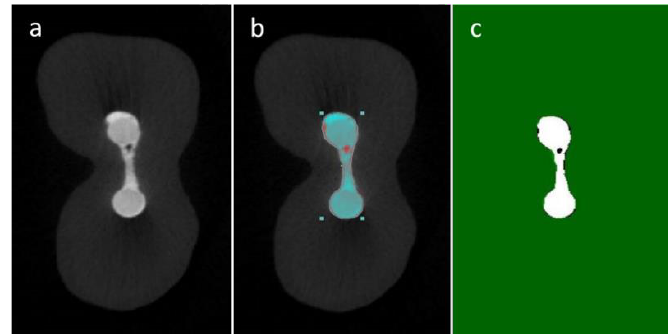
Figure 3. Representative microcomputed tomography (μCT) images showing ( a ) the marked defect, ( b ) the region of interest (ROI) selection on the images, and ( c ) the void detection inside the ROI.